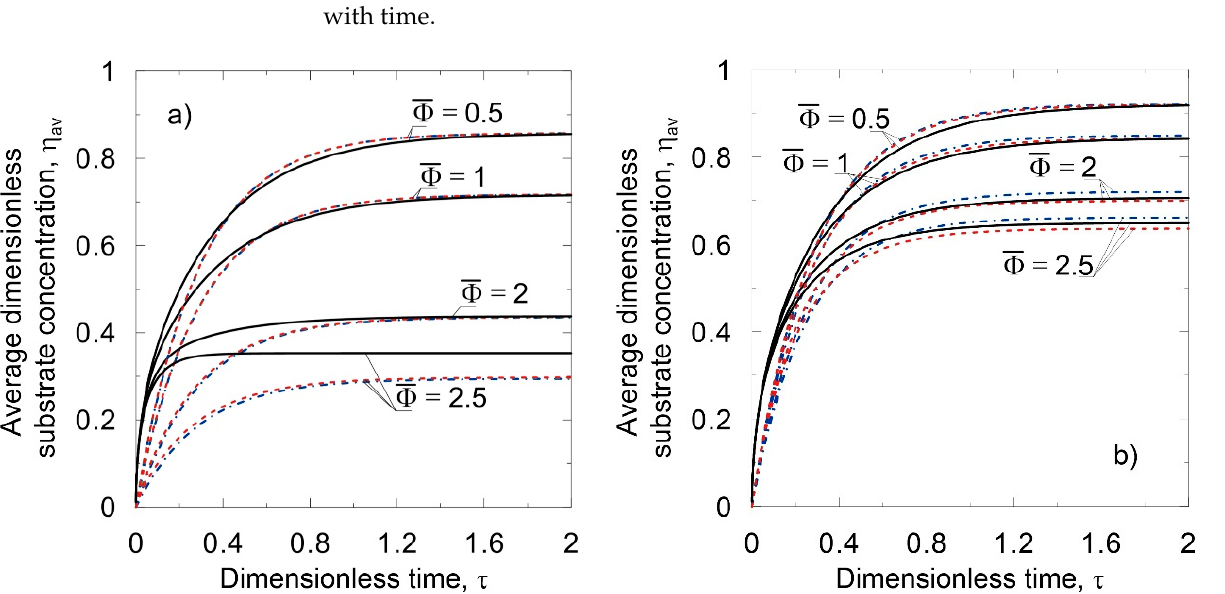
Figure 3. Illustration of the accuracy of linear and nonlinear approximate models AM1 for Monod kinetics ( a ) and Haldane kinetics ( b ); Method of lines; Linear approximate model; ‐ ‐ ‐ Nonlinear approximate model; ( a ) oxidation of nitrite; ( b ) glucose utilization.